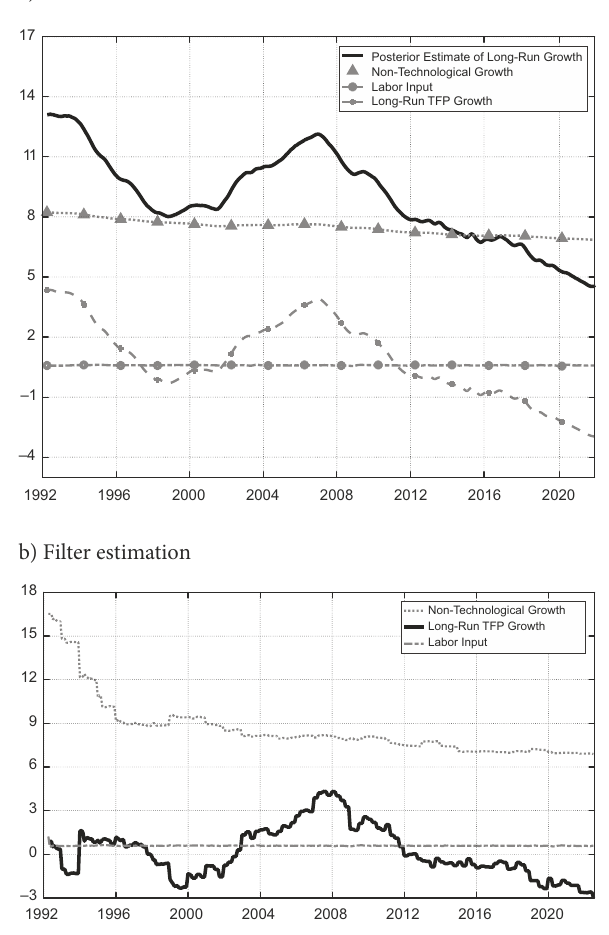
Figure 8. Labor-productivity decomposition of the